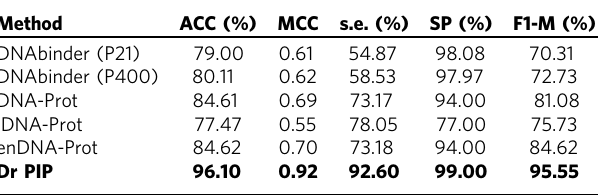
Table 3 | Performance of top performing methods on an independent dataset 29